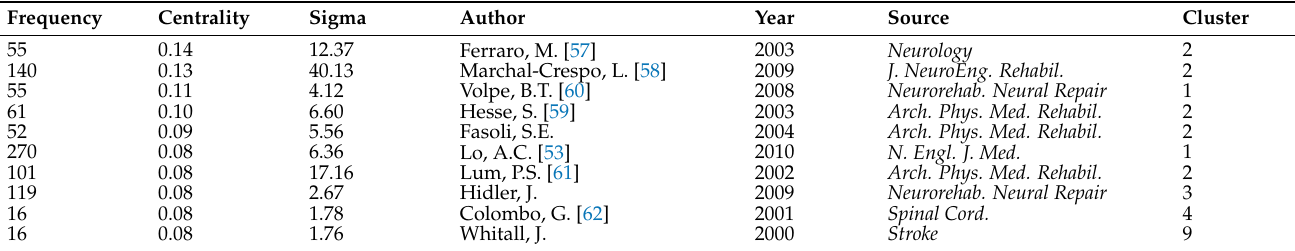
Table 7. Top 10 betweenness centrality values.